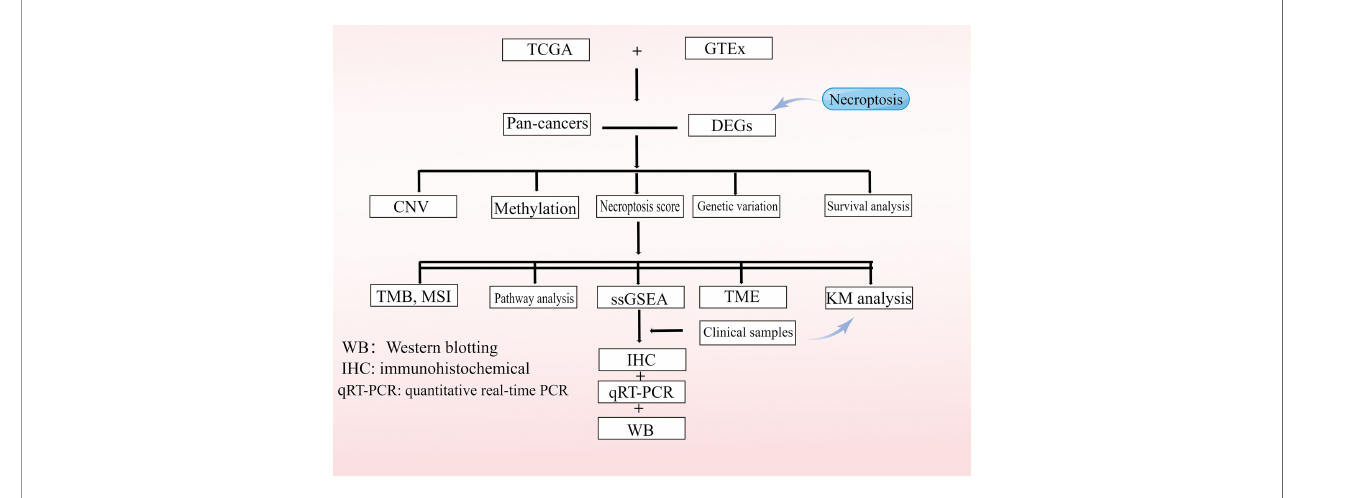
FIGURE 1 | Flowchart of the